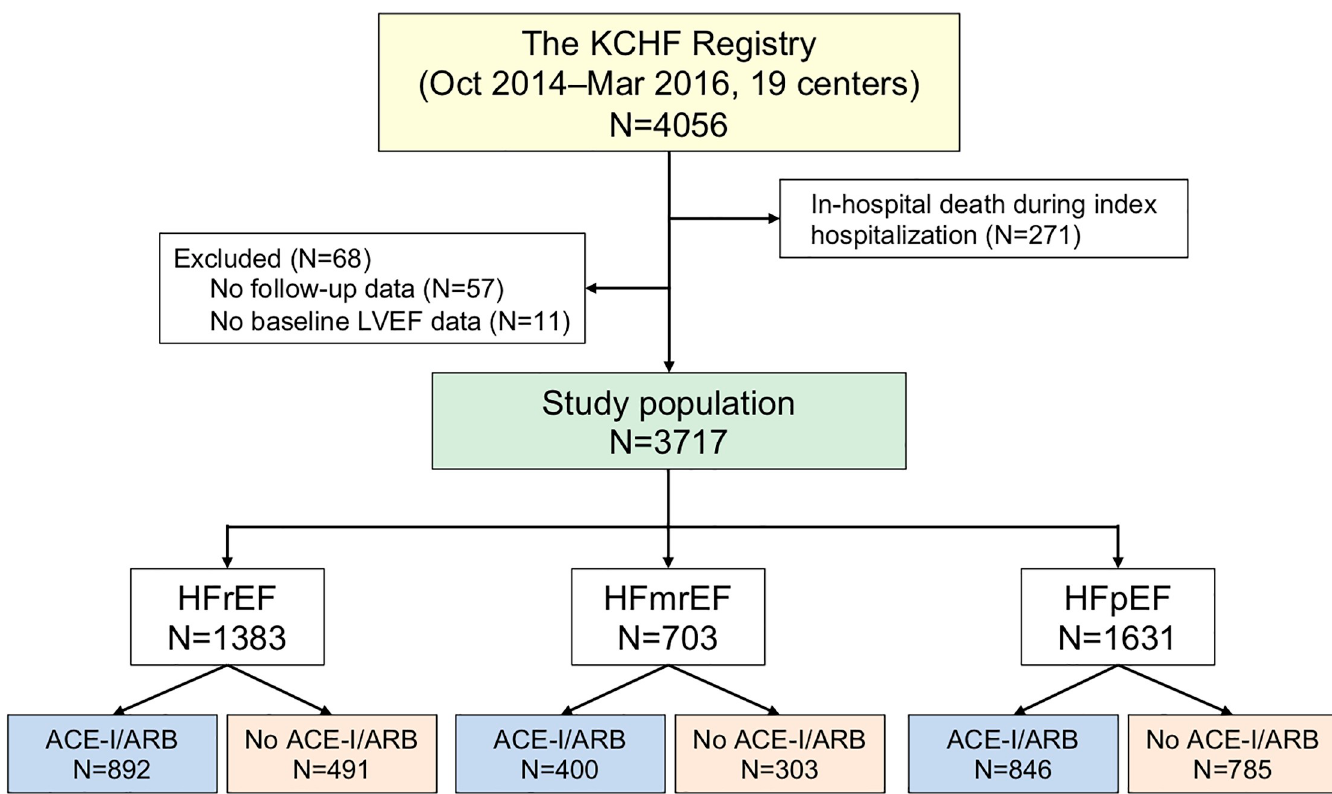
Fig 1. Study flowchart. A total of 3717 patients were included in this study from the KCHF Registry. ACE-I, angiotensin-converting enzyme inhibitors; ARB, angiotensin receptor blockers; HFmrEF, heart failure with mid-range ejection fraction; HFpEF, heart failure with preserved ejection fraction; HFrEF, heart failure with reduced ejection fraction; LVEF, left ventricular ejection